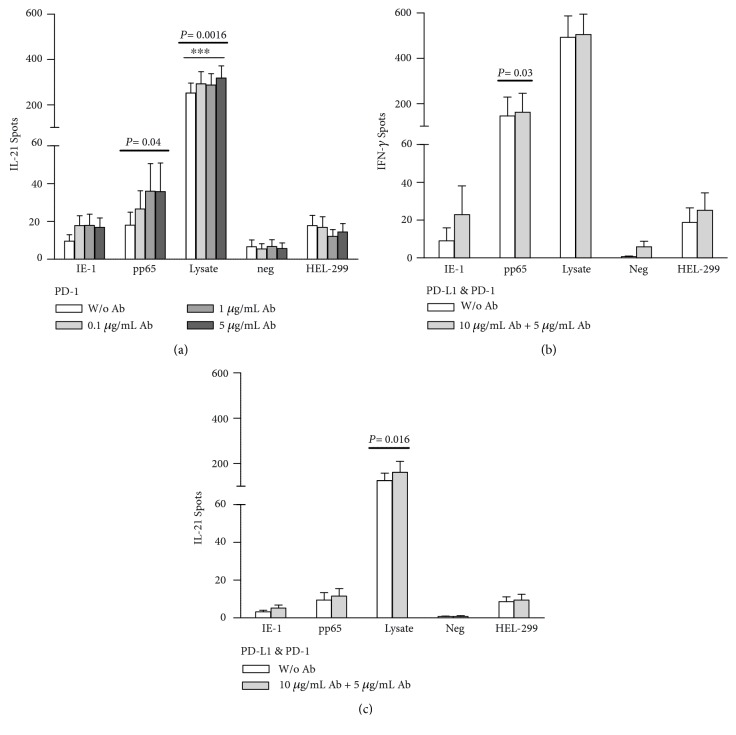
Increase of CMV-specific cytokine secretion by PD-1 and combined PD-L1 and PD-1 antibodies. The figure shows both the IL-21 production without and with the addition of PD-1 antibodies (a) and the IFN-γ (b) and IL-21 (c) production without and with the combined addition of PD-L1 and PD-1 antibodies. Lymphocytes of 28 kidney transplant patients were either stimulated with CMV IE-1, pp65, CMV lysate (lysate), or HEL-299 lysate or remained unstimulated (neg). Unstimulated cells (neg) served as a negative control for stimulation with IE-1 and pp65, and the HEL-299 lysate as a negative control for the CMV lysate. For the PD-1 blockade, the antibody was added to the cell cultures at concentrations of 0.5, 1, and 5 μg/ml. For the combined blockade, the PD-L1 antibody was used at a concentration of 10 μg/ml, and the PD-1 antibody at a concentration of 5 μg/ml. IL-21 secretion after addition of PD-1 antibodies was determined in 15 patients, IFN-γ and IL-21 production after addition of both antibodies in seven patients each. Mean and standard of the mean (SEM) of spot numbers are depicted. The effect of PD-1 antibodies was analyzed by one-way ANOVA with a posthoc test. Values above the bold horizontal lines indicate significant P values obtained by the Friedman test, a significant result of Dunn's posthoc test (to compare the various concentrations) is given above the thin horizontal line (∗∗∗
P < 0.001). The effect of both antibodies in combination was determined by the Wilcoxon matched pairs test.